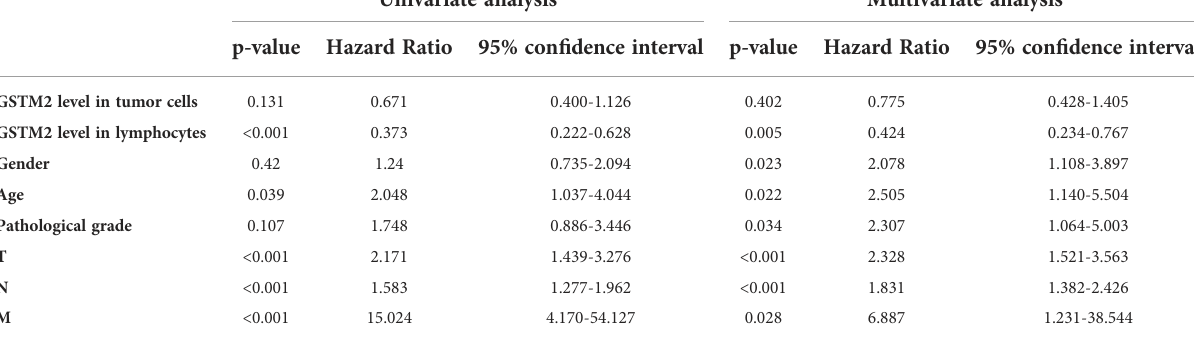
TABLE 2 Univariate and multivariate analyses identi fi ed GSTM2 level in lymphocytes as an independent prognostic factor for colon cancer.